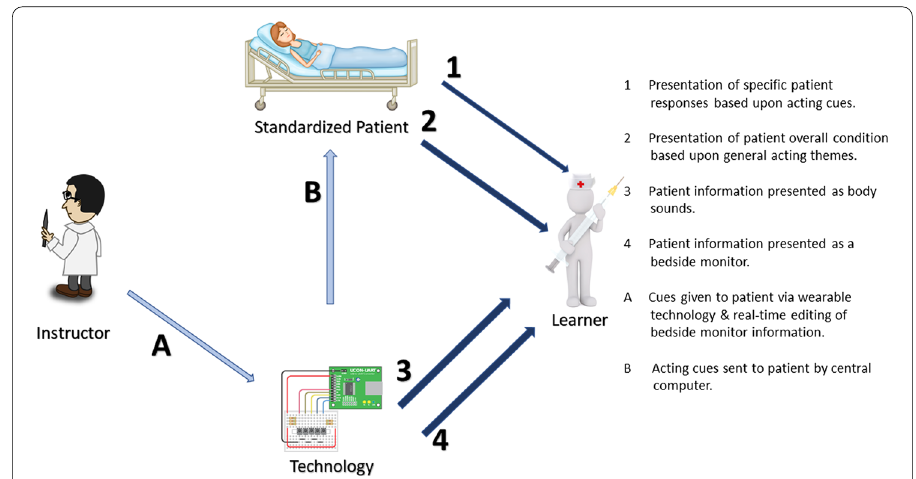
Fig. 1 Hybrid simulation theoretical